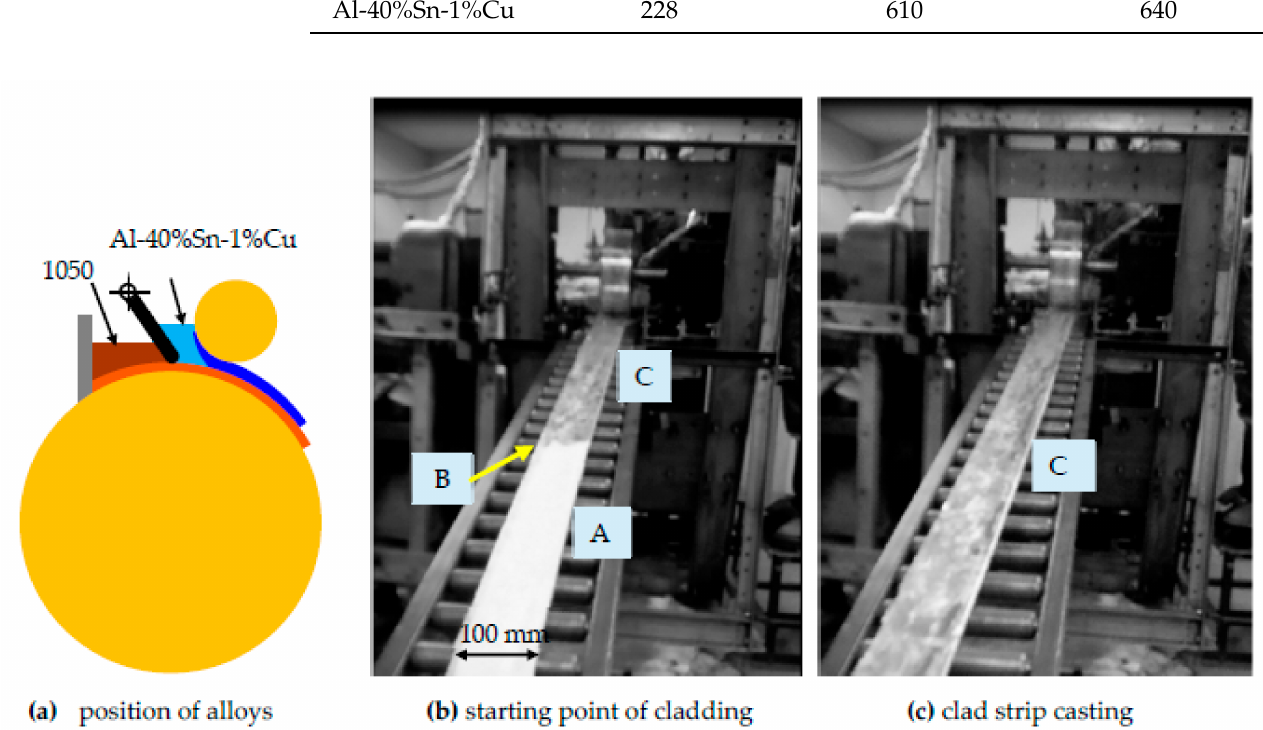
Figure 26. Casting of clad strip consisting of 1050 and Al-40%Sn-1%Cu. ( a ) Position of alloys, ( b ) starting point of cladding, ( c ) clad strip casting. A: 1050 base strip only, B: starting point of cladding, C: clad strip of 1050 and